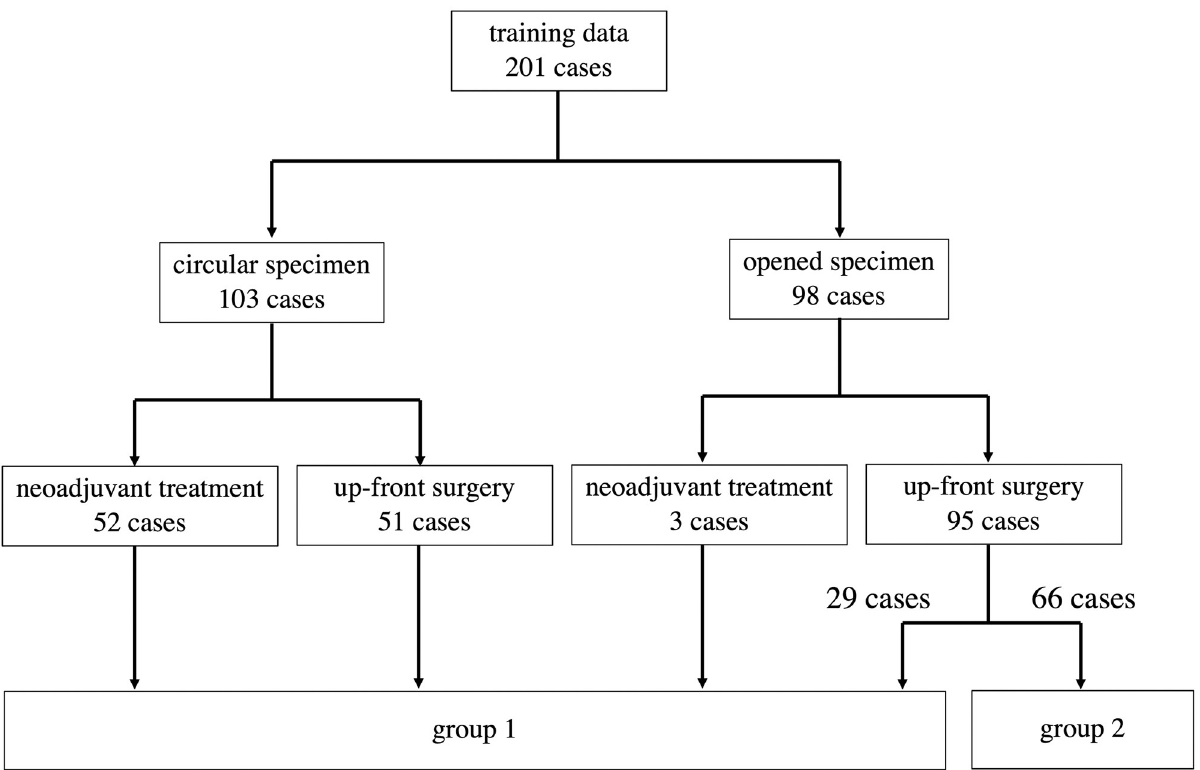
Fig 1. Details of a total of 201 cases used as training data. Group 1 images were used to prepare ground-truth labels for segmentation. Group 2 images were used as ground-truth labels having pathological information of T staging alone.